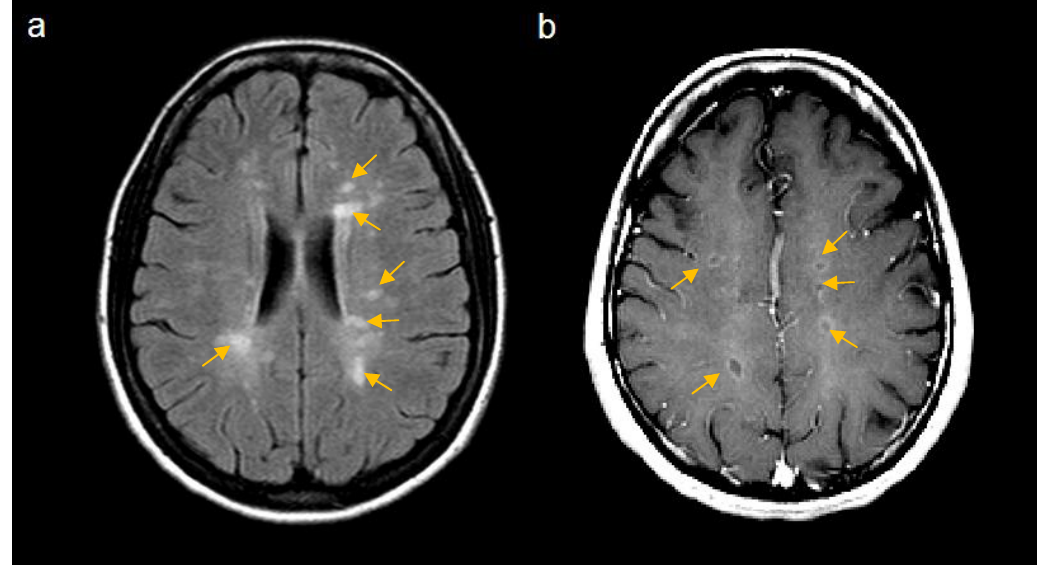
Figure 2. Axial magnetic resonance imaging showing ( a ) hyperintense lesions (arrows) on T2 weighted images and ( b ) ring, gadolinium (GAD)-enhancing lesions (arrows) on T1 weighted images.